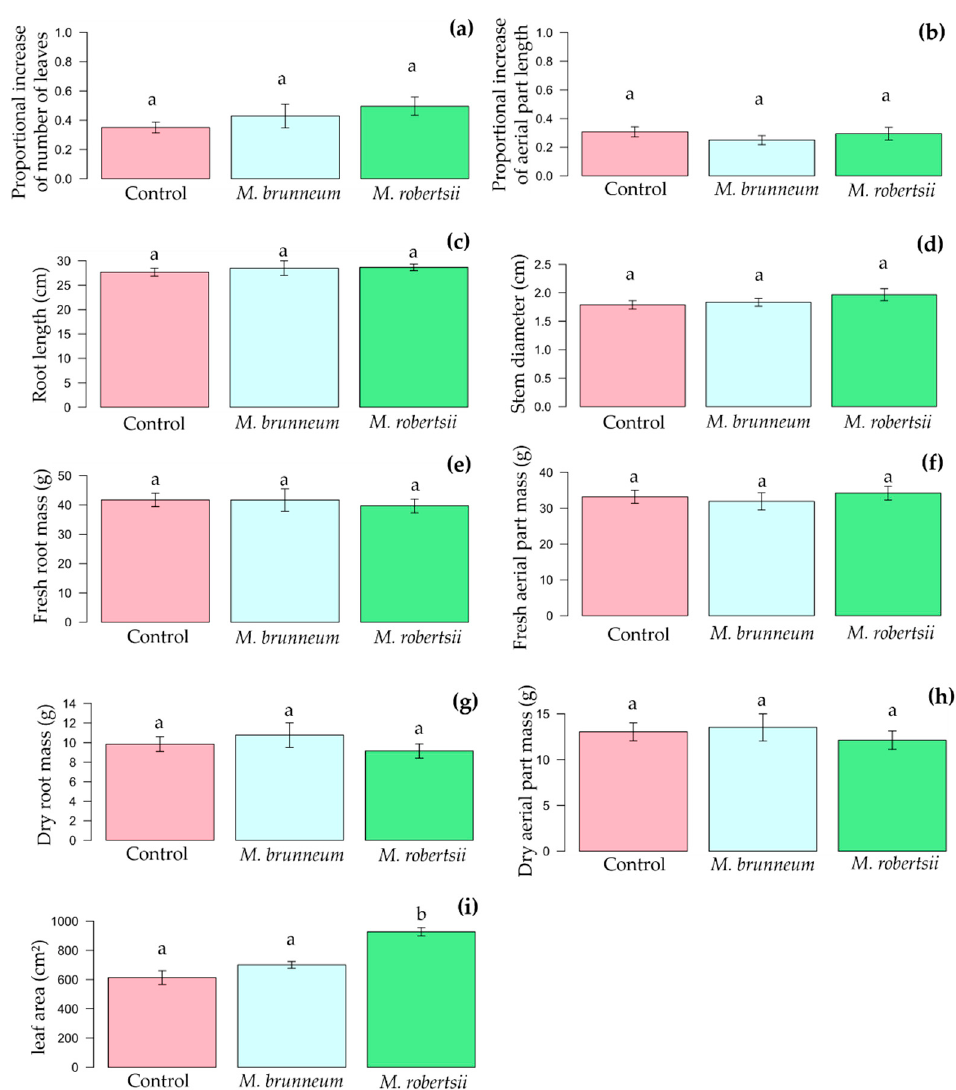
Figure 2. Growth variables of coffee seedlings inoculated with Metarhizium robertsii or Metarhizium brunneum by soil drench. ( a ) number of leaves; ( b ) length of aerial part; ( c ) length of roots; ( d ) stem diameter; ( e ) fresh mass of roots; ( f ) fresh mass of aerial part; ( g ) dry mass of roots; ( h ) dry mass of aerial part; ( i ) leaf area. Inoculation of 30 mL of each isolate suspension was to the surface of the soil in each coffee seedling while the control received a sterile solution of Tween 0.05%. Bars with the same letters are not statistically different.